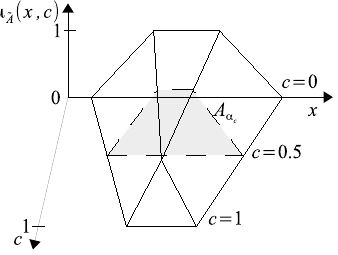
Figure 13. Visualization of the vertical α c -cut A α c =